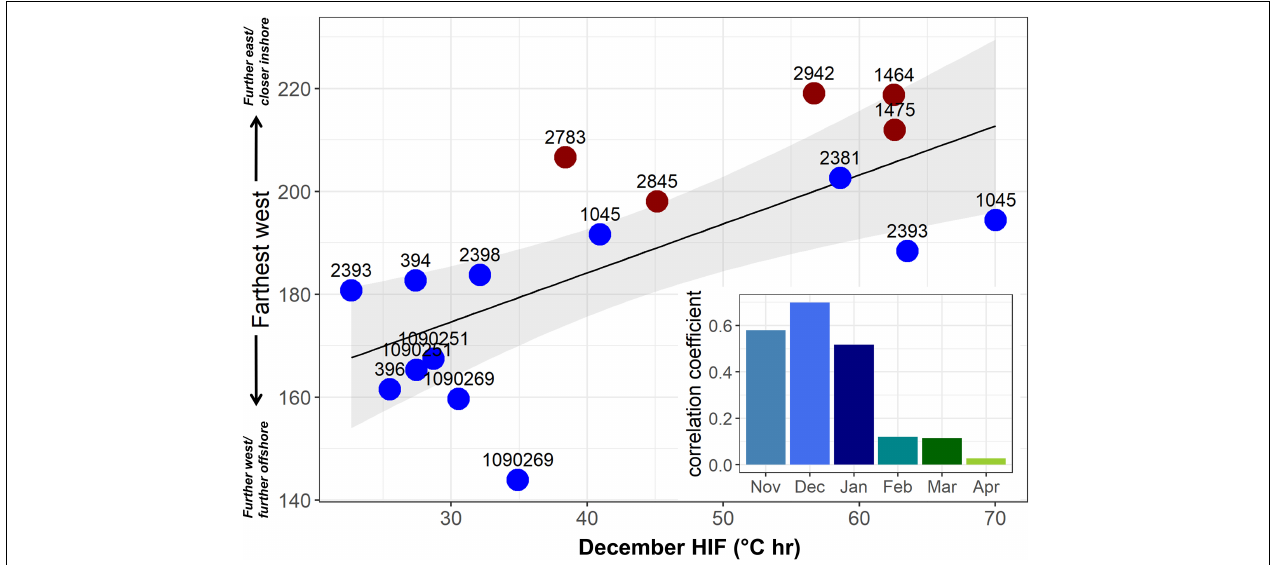
FIGURE 6 | Mean December HIF versus farthest westward location (degrees east, reached between January and June) for the 15 fish which moved offshore of the California Current in fall, and returned during spring, with tag number also shown. Blue circles show fish which departed the California Current in fall north of 40 ◦ N, red circles show fish which departed the California Current south of 40 ◦ N. Inset shows linear correlation coefficient between mean HIF and farthest west (degrees east) by month.